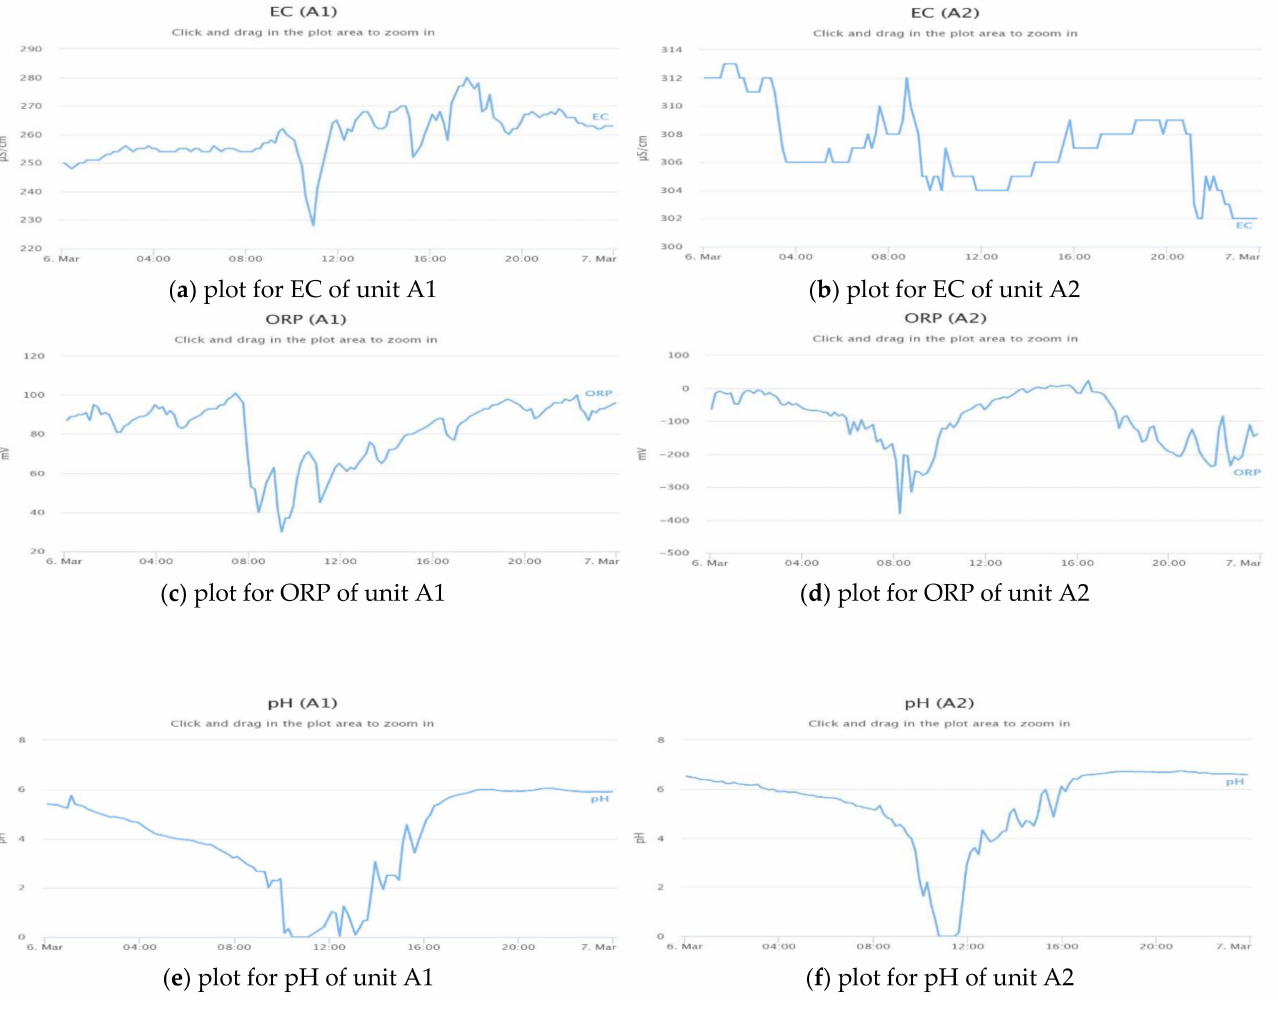
Figure 9. Snapshots of historical data for EC, ORP, and